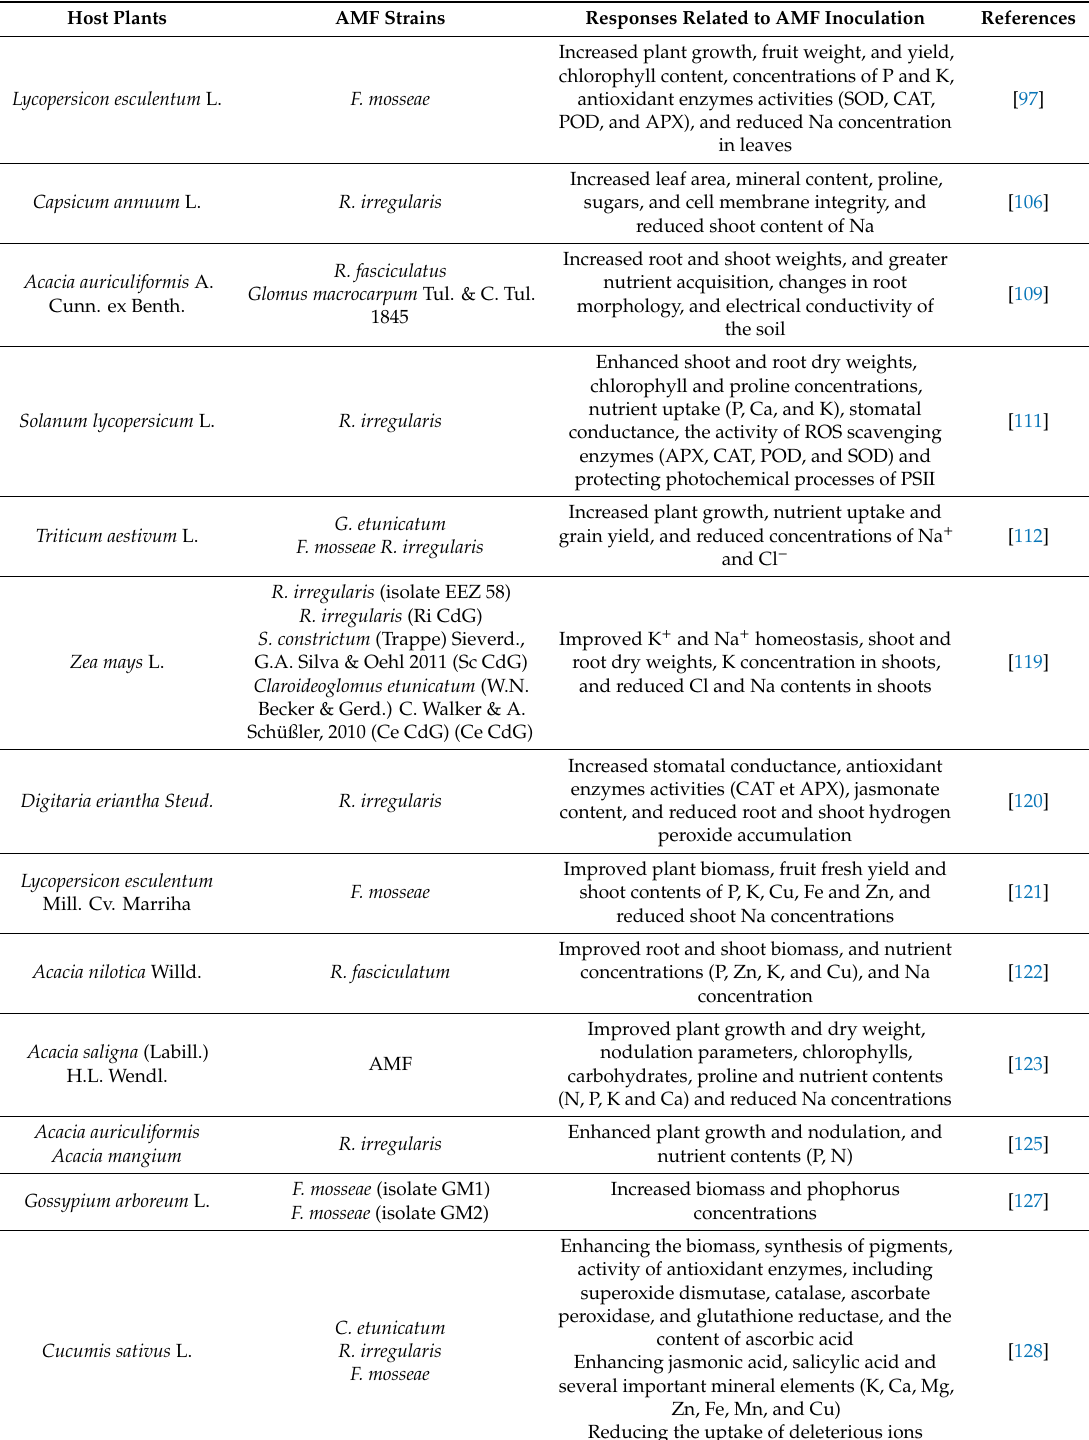
Table 4. Contribution of AMF in helping plants to cope with salinity